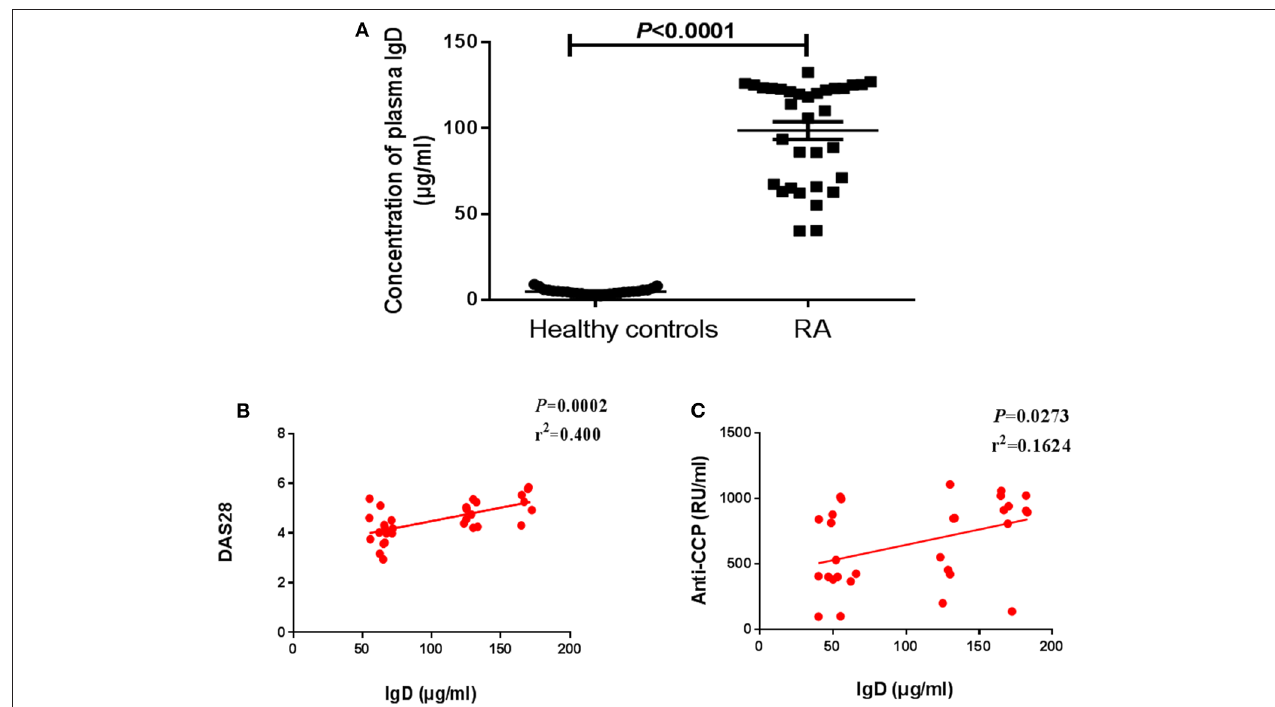
FIGURE 1 | Levels of plasma sIgD in RA patients and healthy controls. (A) Plasma IgD levels of healthy controls ( n = 27) and RA patients ( n = 33). Pearson’s correlation analyses were shown for the association of IgD with DAS28 scores (B) and anti-CCP (C) in RA